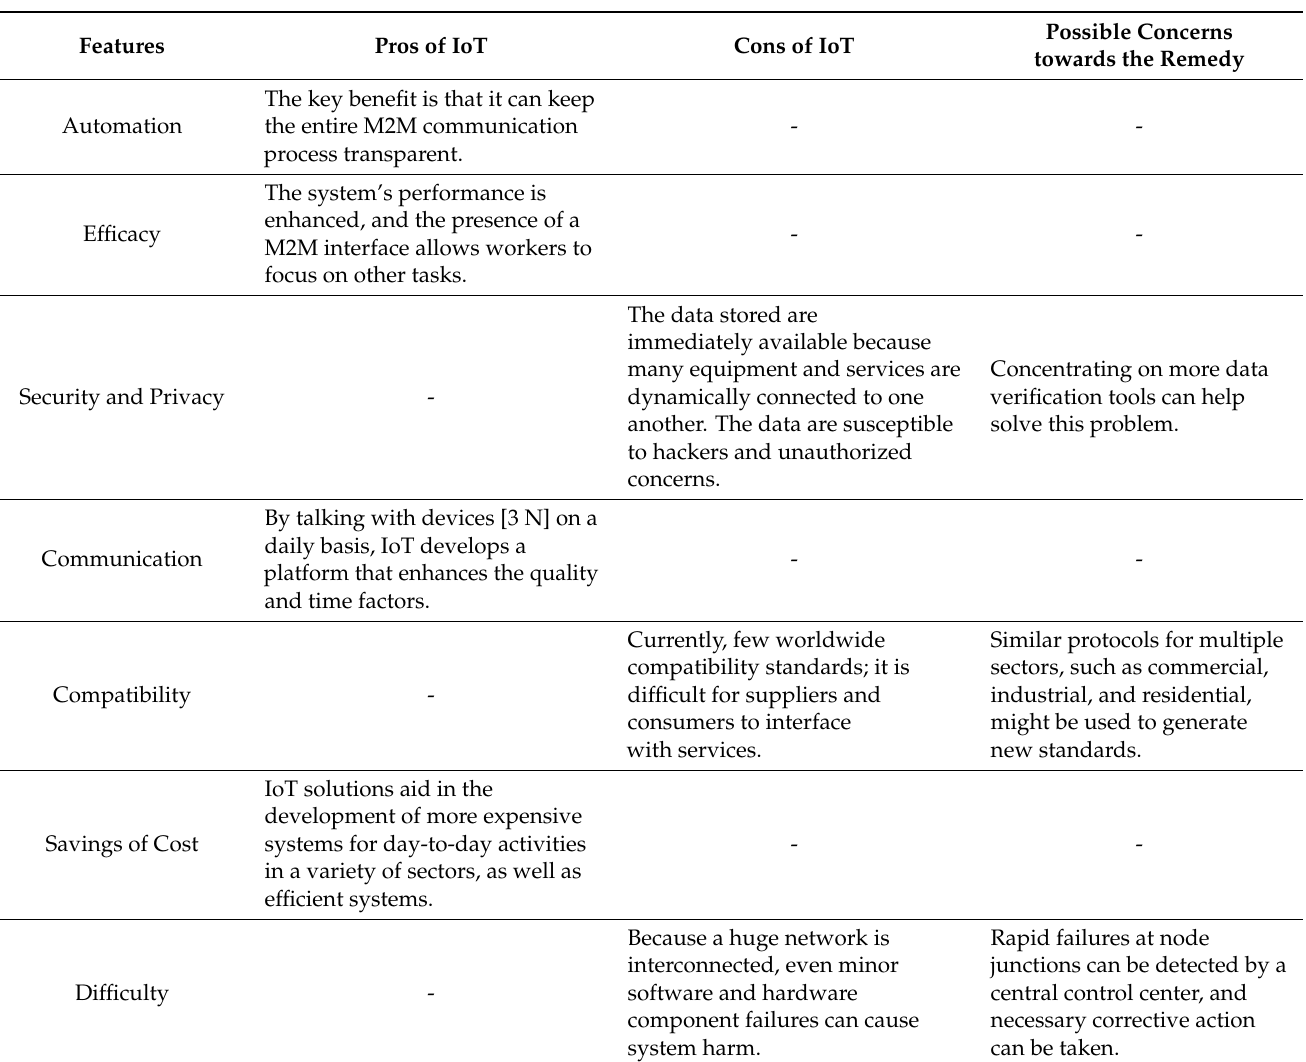
Table 8. Benefits and drawbacks of